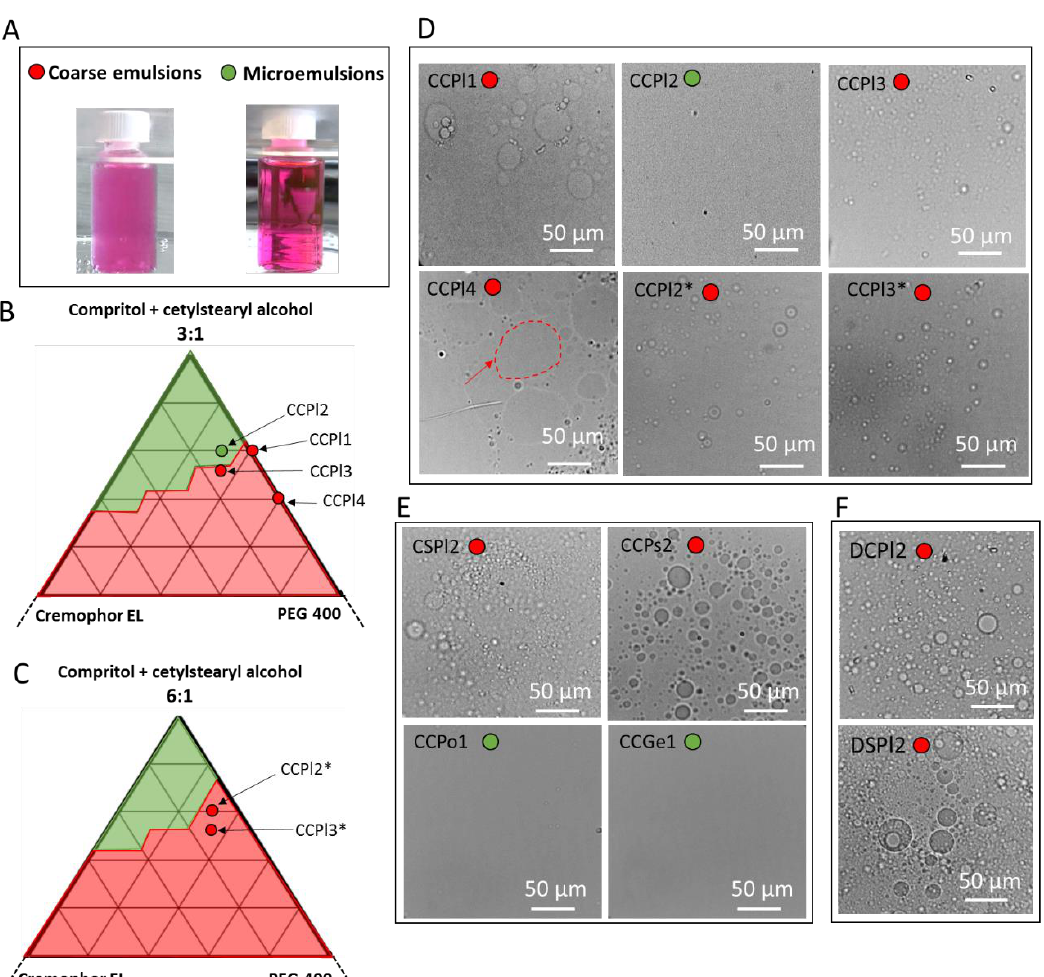
Figure 2. Appearance of the non-aqueous emulsions observed at 70 °C: emulsions (cloudy) and microemulsions (transparent). The hydrophilic phase is loaded with a probing pink dye (Rho) (A). Pseudo-ternary phase diagrams of emulsions with Compritol 888 ATO:cetylstearyl alcohol at 3:1 ratio ( B ) and 6:1 ratio ( C ). Optical microstructure of emulsions with Compritol 888 ATO:cetylstearyl alcohol ( D ). Effect of a different surfactant (CSPl2) and different hydrophilic carriers (CCPs2, CCPo1 and CCGe1) on the microstructure of Compritol 888 ATO-based emulsions ( E ). Optical microstructure of Dynasan 118-based (DCPl2 and DSPl2) emulsions ( F ).